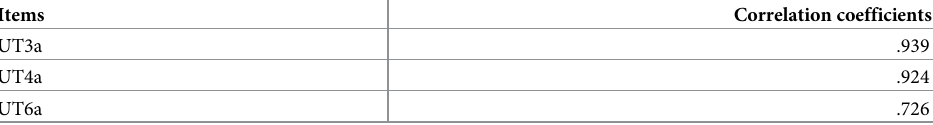
Table 11. Correlation coefficients between the first factor of distrust and the variables that build it. Items